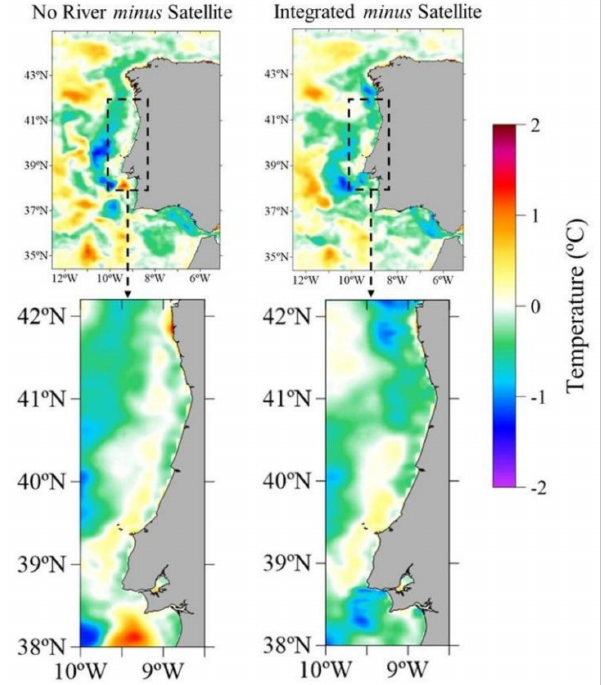
Figure 9. Difference between surface temperature maps for the entire domain ( top ) and a zoom over the area of interest on the west coast of the IP ( bottom ) produced by: no-rivers minus satellite ( left ) and integrated minus satellite ( right ) at the peak flow period (20 March